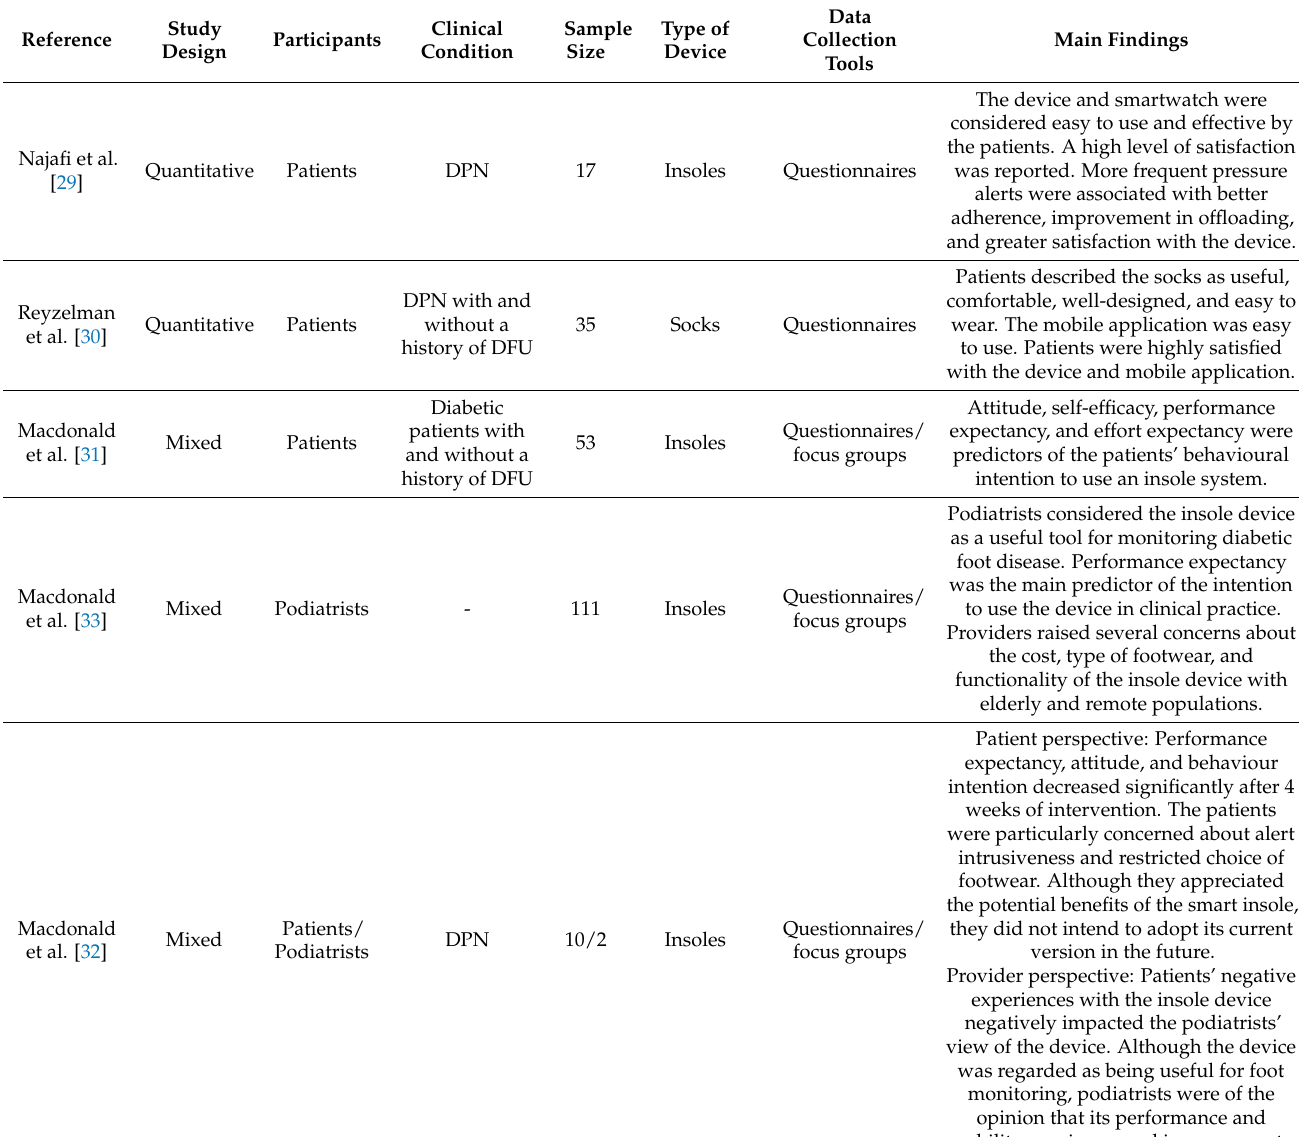
Table 1. Summary of studies exploring patient and provider perspectives on the usability of smart wearable devices in people at high risk of diabetic foot